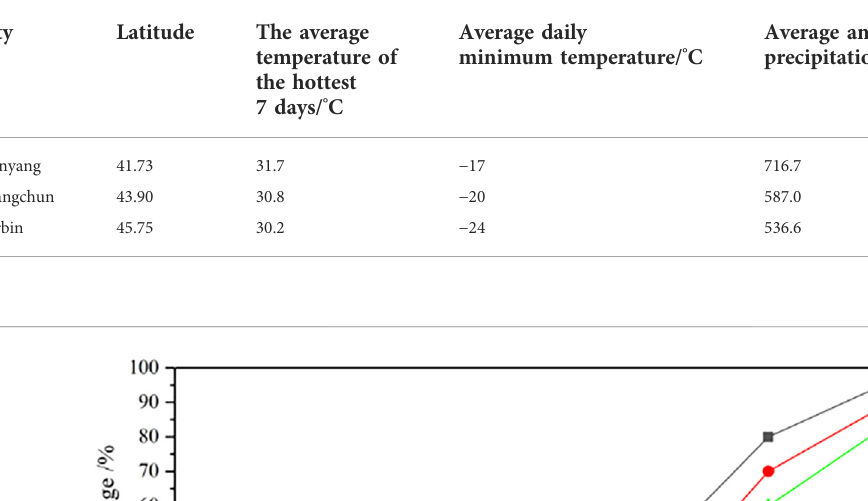
TABLE 5 Climate conditions in the seasonal frozen area of northeast.